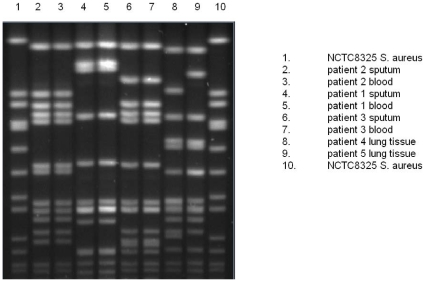
Pulsed-field gel electrophoresis of MRSA isolates (Sma1 macrorestriction).